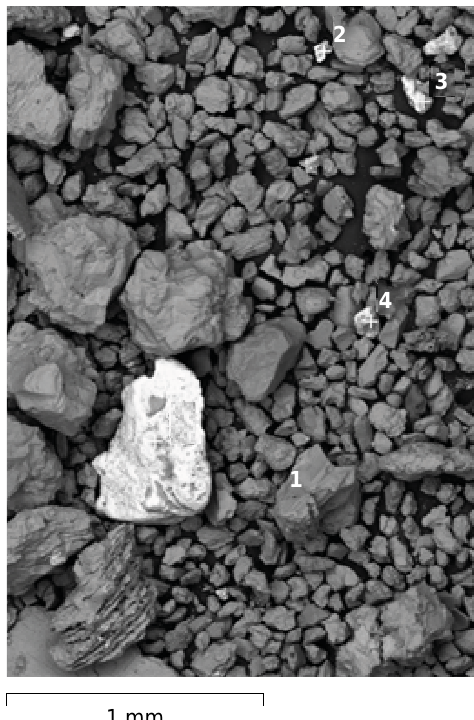
Figure 5. Scanning Electron Microscopy images of sand particles from sample 4 (area 1).